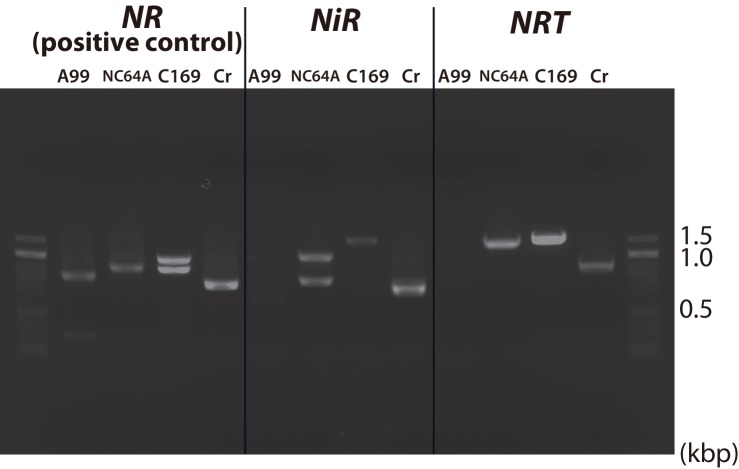
PCR of nitrate assimilation genes.PCR amplification of genomic DNA corresponding to the genes NRT2, NiR and NR (positive control) was performed in Chlorella sp. A99 (A99), Chlorella variabilis NC64A (NC64A), Coccomyxa subellipsoidea C169 (C169) and Chlamydomonas reinhardtii (Cr).